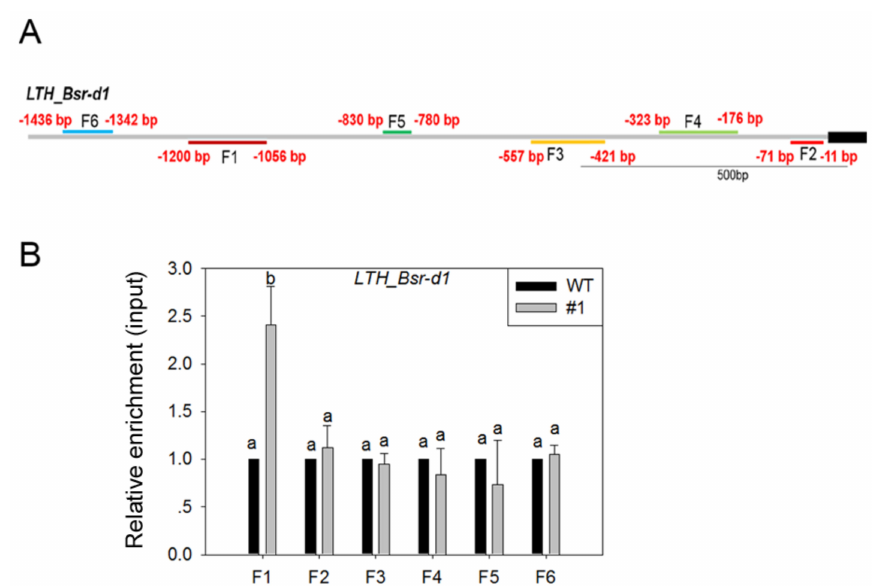
Figure 8. Relative enrichment of MoSDT1-GFP in the promoter of OsBsr-d1 . ( A ) Chromatin immunoprecipitation-quantitative PCR (ChIP-qPCR) primer pairs in the promoter of OsBsr-d1 . ( B ) Relative enrichment of MoSDT1-GFP in the promoter of OsBsr-d1 . Di ff erent letters represent statistically significant di ff erences ( p < 0.05).